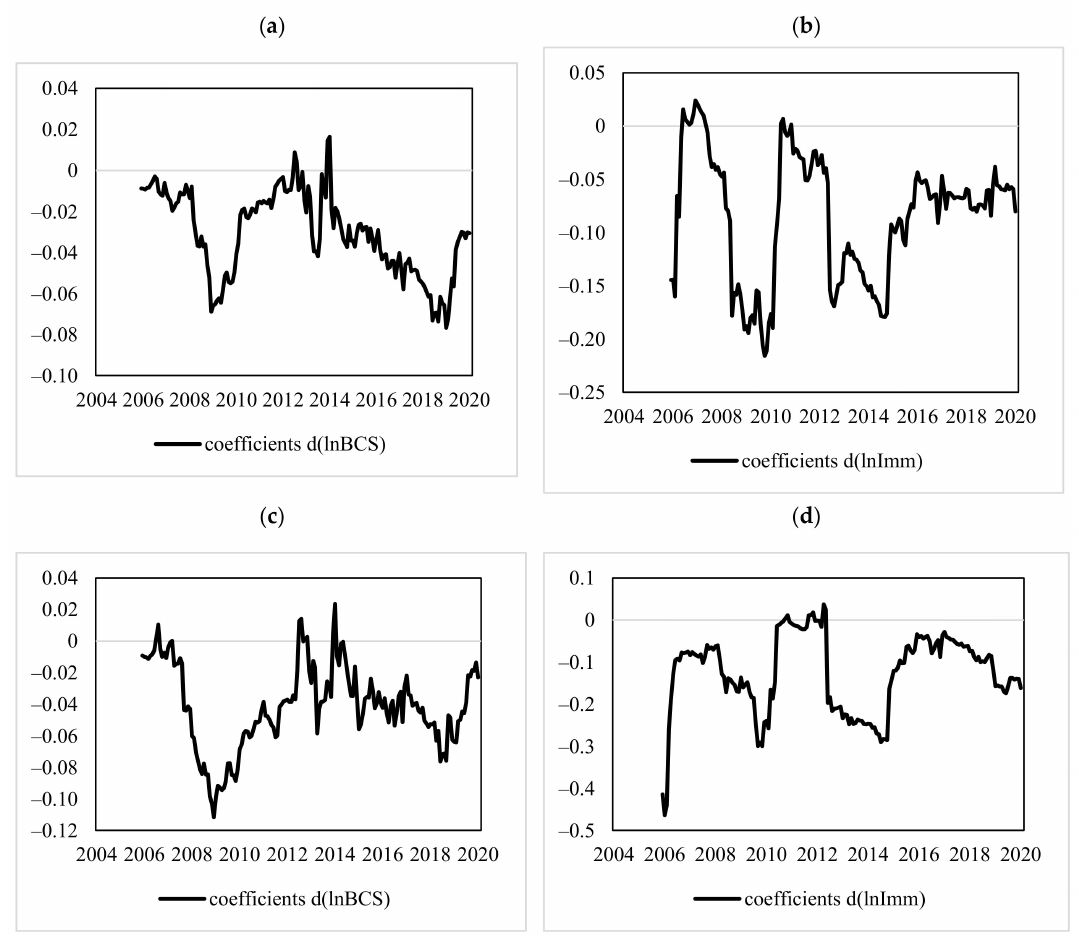
Figure 4. Rolling regression coefficients for the BEMS and Imm variables (24-month window). ( a ) De- pendent variable: LN personal vehicles; ( b ) Dependent variable: LN personal vehicles; ( c ) Dependent variable: LN pedestrians; ( d ) Dependent variable: LN